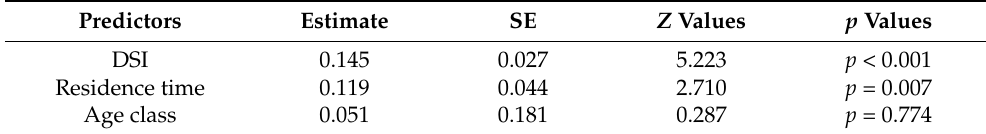
Table 5. The results of the GLMM to determine the factors that affect the coalition of Tibetan macaques.